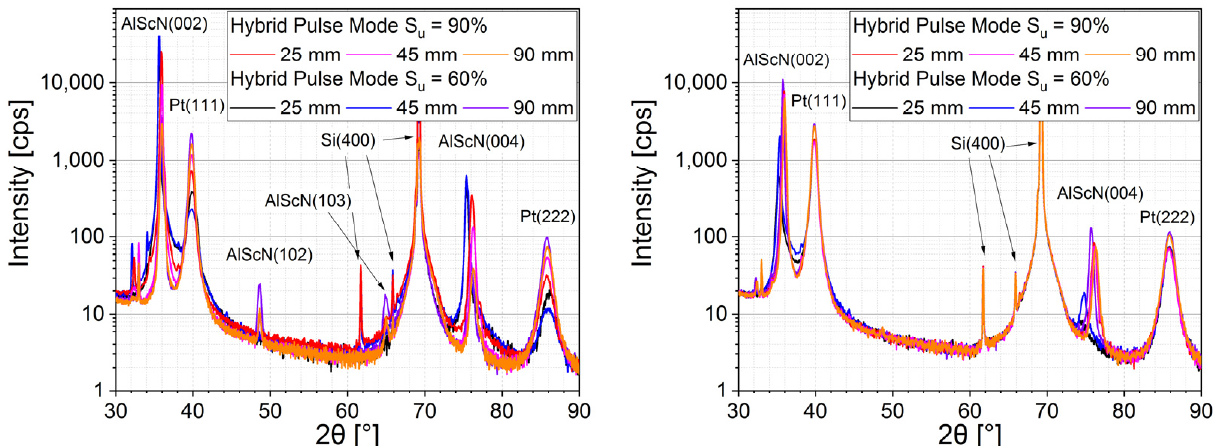
Figure 3. θ –2 θ scan of 2.5 µ m ( left ) and 0.9 µ m ( right ) AlScN films at different radial positions (25 mm, 45 mm, 90 mm); peaks labeled as Si(400) are the Si substrate peaks by Cu K α 1/2 (69.2 ◦ ), Cu K β 1 (61.7 ◦ ) and Cu W L α 1 (65.9 ◦ ); the peaks at 32.2 ◦ and 34.2 ◦ are the AlScN(002) Peaks by Cu K β 1 and Cu WL α 1 , as well as Si(200) by Cu K α 1 at 33.0 ◦ , respectively.